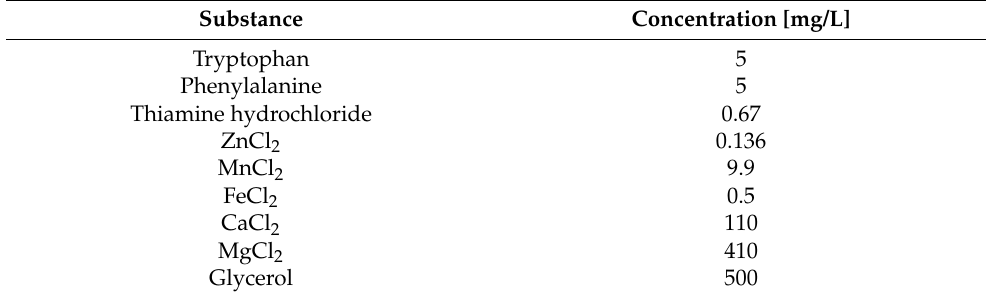
Table A1. Substances added to one liter of demineralized water for preparing the feed solution.